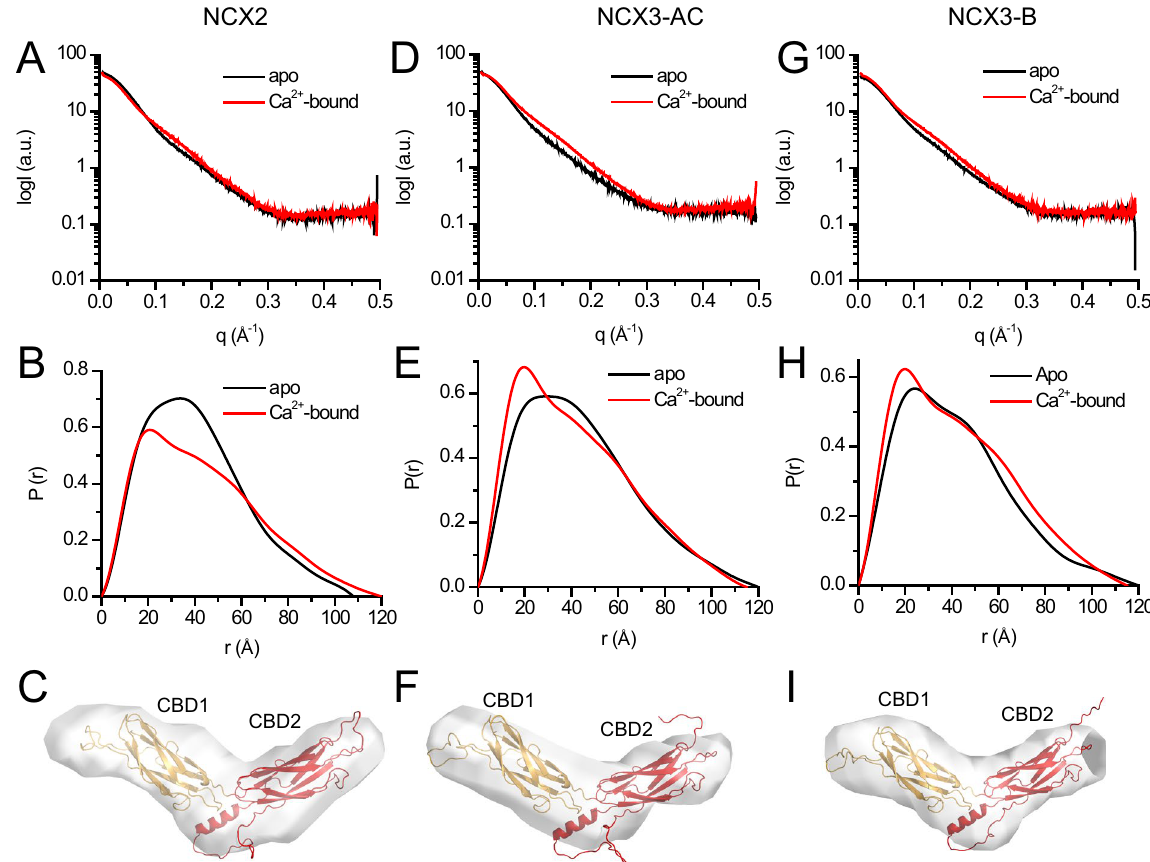
Figure 2. Ab-initio modelling of CBD12 from NCX2 and NCX3. ( A , D , G ) Experimental SAXS curves of CBD12 from NCX2 ( A ), NCX3-AC ( D ), and NCX3-B ( G ) in the presence (red) and absence (black) of Ca 2 + . ( B , E , H ) Paired-distance distribution functions of CBD12 from NCX2 ( B ), NCX3-AC ( E ), and NCX3-B ( H ) in the presence (red) and absence (black) of Ca 2 + as determined using GNOM. ( C , F , I ) Ab-initio model of CBD12 from NCX2 ( C ), NCX3-C ( F ), and NCX3-B ( I ) in solution in the presence of Ca 2 + . The homology model of CBD12 was fit into the molecular envelope using SUPCOMB. CBD1 and CBD2 are presented as orange and red cartoons,